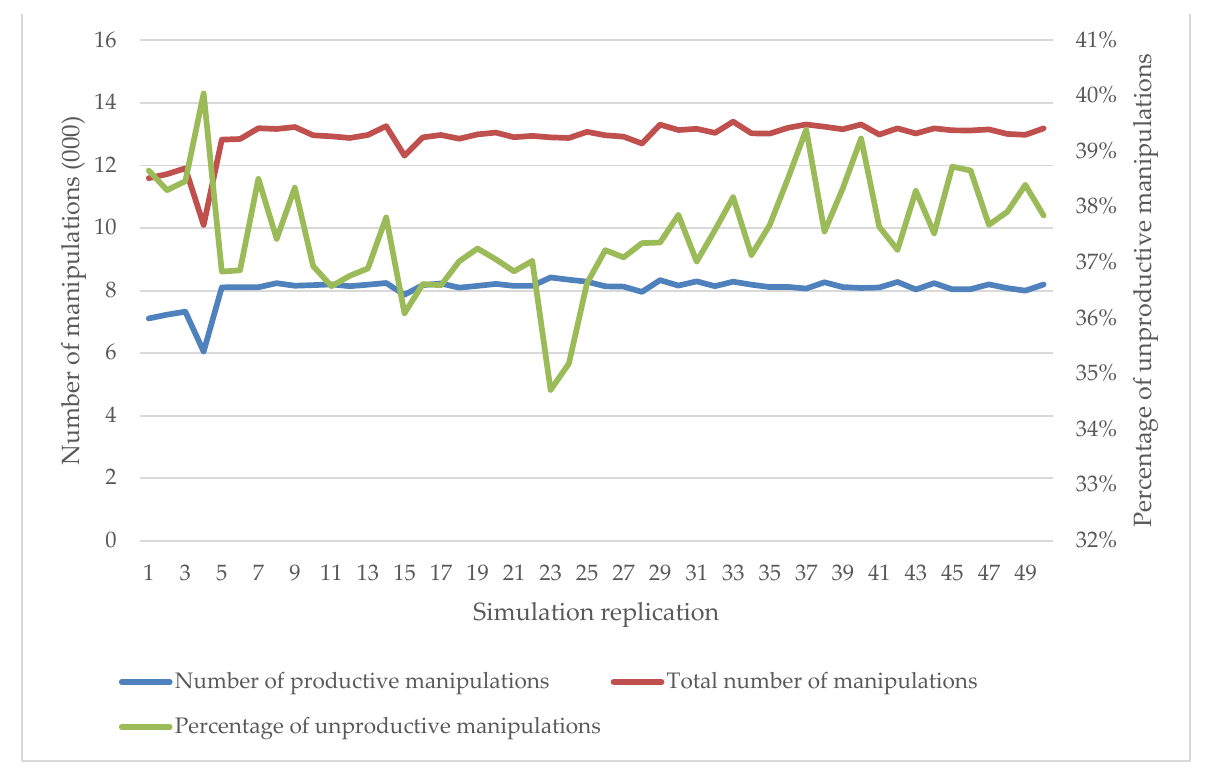
Figure 8. Numbers of total and productive manipulations as well as the percentage of unproductive manipulations in the simulation.